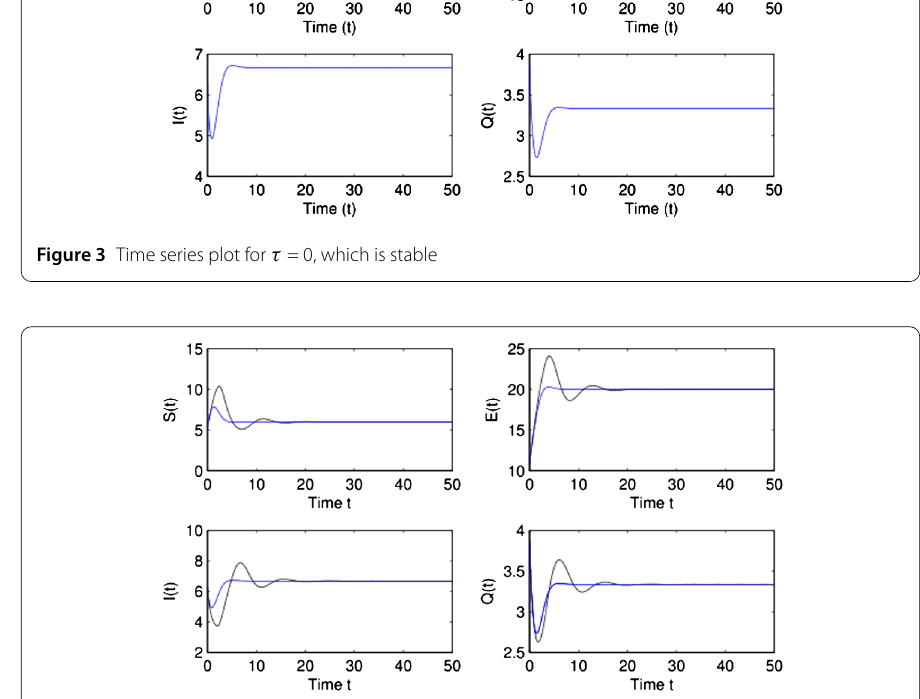
Figure 4 Time series plot for τ (cid:10) = 0 but very small τ , which is